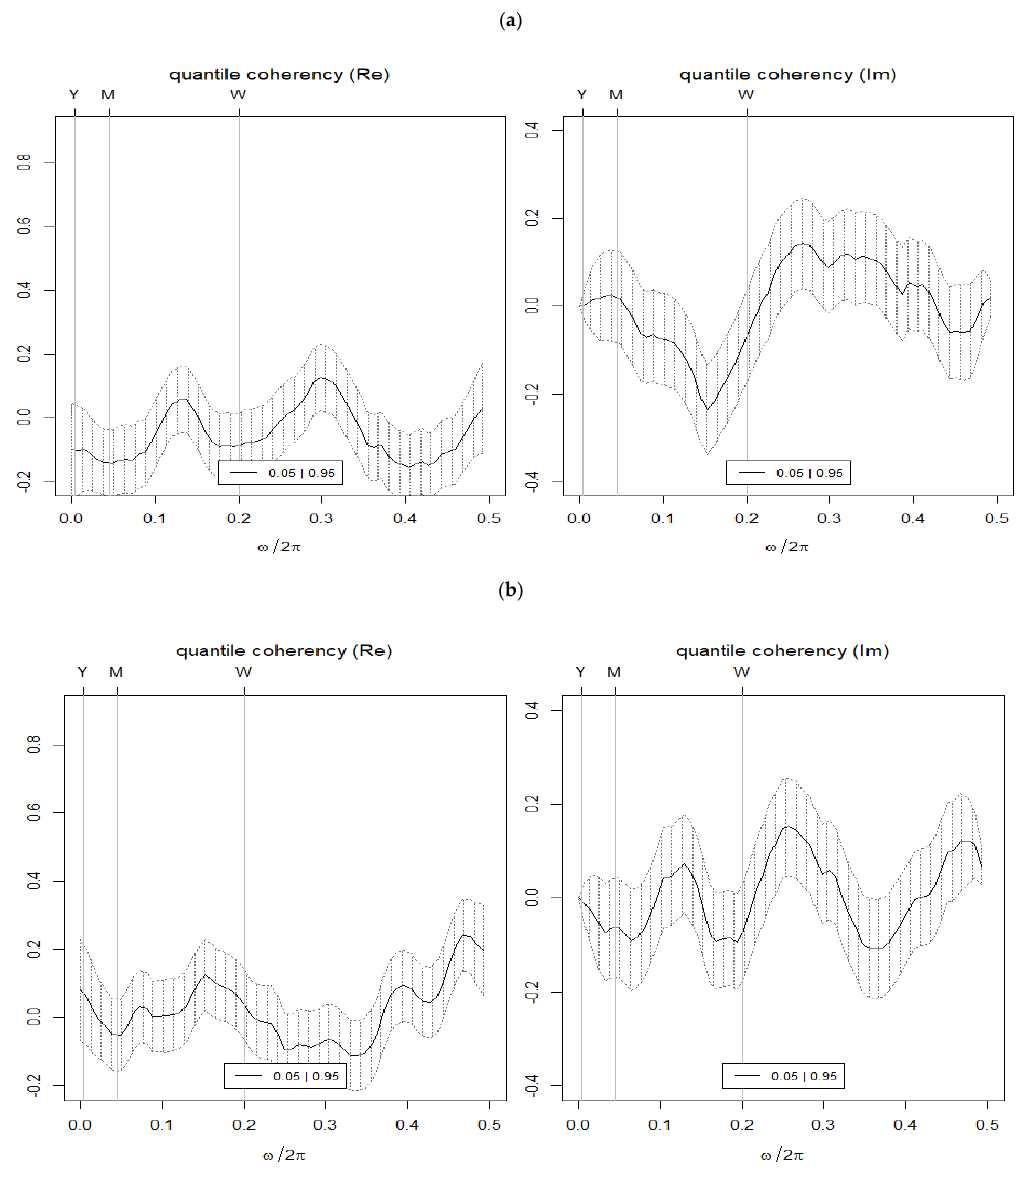
Figure 2. Interdependence between the 0.05|0.95 quantiles of joint distribution. ( a ) BTC vs. USA-EPU. ( b ) BTC vs. CHN-EPU. Note: (i) BTC = Bitcoin; CHN_EPU = Chinese economic policy uncertainty